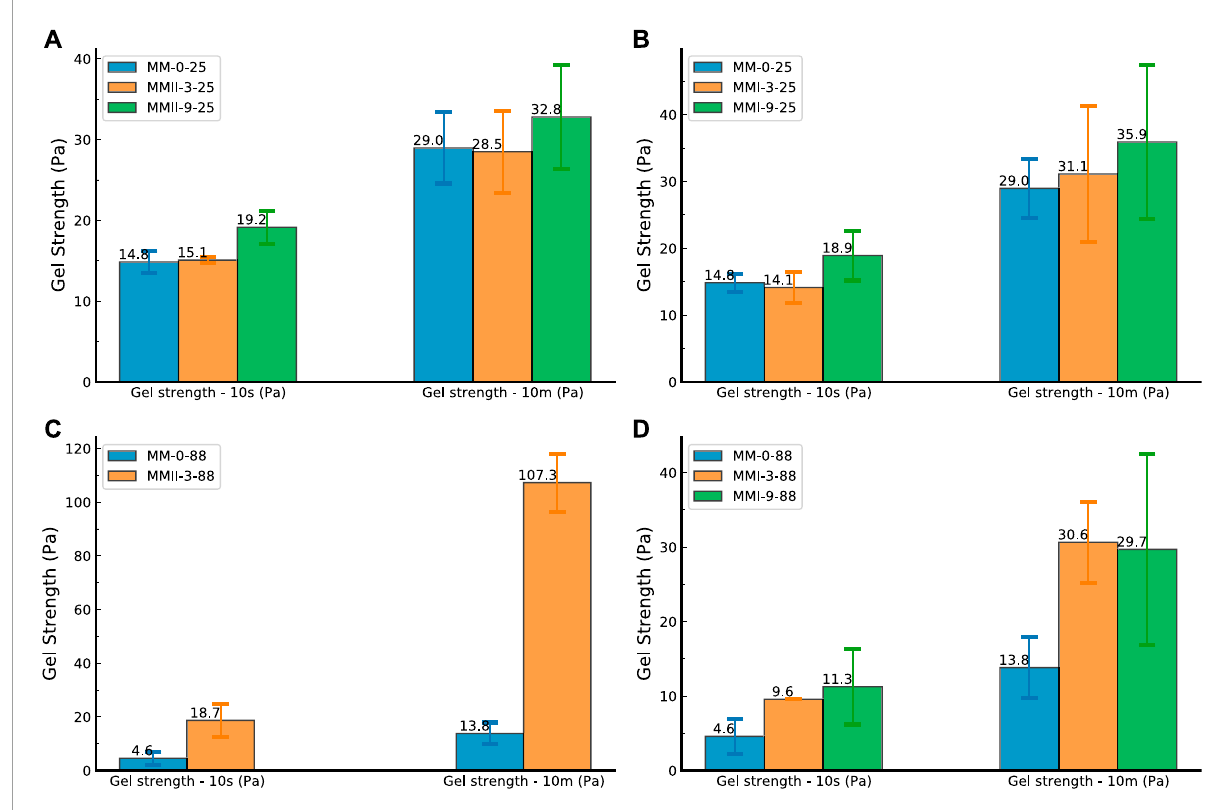
FIGURE 7 Gel strength of slurry samples. (A) Slurry samples (mixed with MMII) tested under 25 ° C; (B) slurry samples (mixed with MMII) tested under 88 ° C; (C) slurry samples (mixed with MMI) tested under 25 ° C; and (D) slurry samples (mixed with MMI) tested under 88 ° C; MMI refers to type I micro-sized magnesium oxide; MMII refers to type II micro-sized magnesium